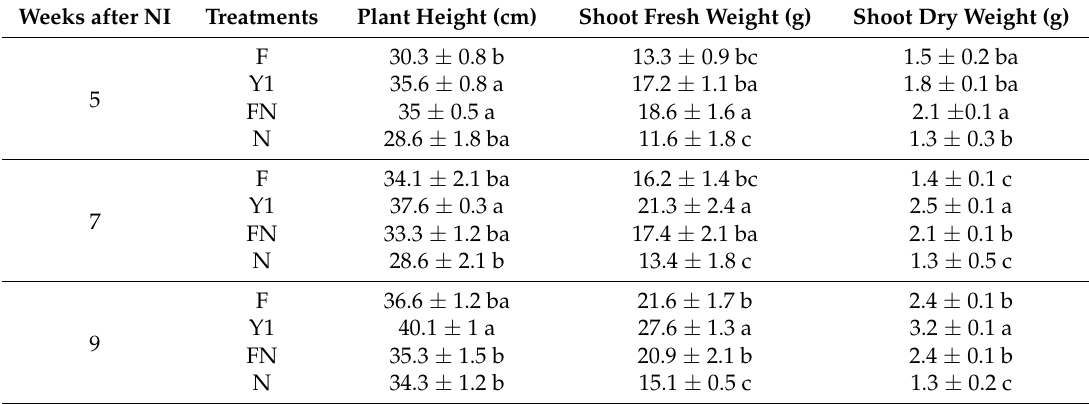
Figure 8. Effect of B. amyloliquefaciens Y1 on number of juveniles in 100 g soils in tomato plants treated with fertilizer medium (F), bacterial culture (Y1), fertilizer medium + commercial nematicide (FN) and commercial nematicide (N) at 5, 7 and 9 weeks after M. incognita infestation. Fertilizer medium was used as control and Mocap was used once as nematacide. Error bars represent standard error of the mean from four replicates. Means with the same letter in same observation time are not significantly different at p ≤ 0.05 when compared with LSD. Table 1. Changes in plant height, fresh root and shoot weight as infected with infested with Meloidogyne incognita.